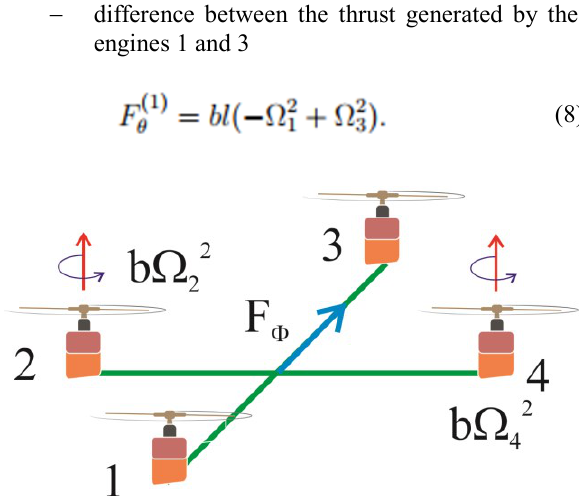
Fig. 5. The moment caused by the difference of thrust generated by engines 1 and 3